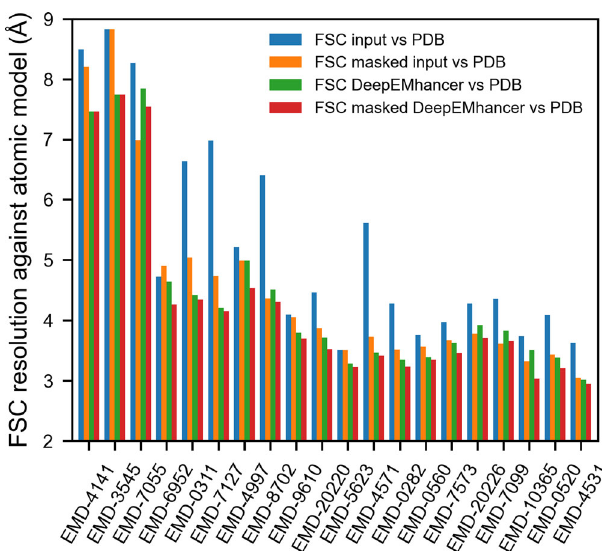
Fig. 2 DeepEMhancer produces better quality maps. DeepRes median local resolution estimation for (1) the input maps (blue), (2) the post- processed maps obtained with Relion postprocessing automatic B -factor (orange), (3) the post-processed maps deposited in EMDB (green) and (4) the post-processed maps obtained with DeepEMhancer (Red). EMDB entries are sorted by published global